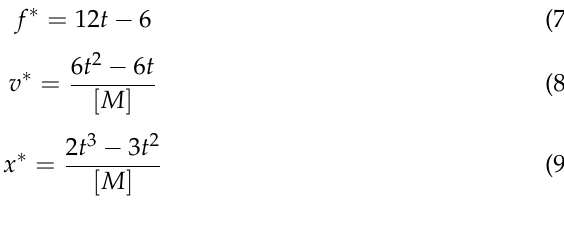
Table 3. Pontryagin’s Trajectory Variable